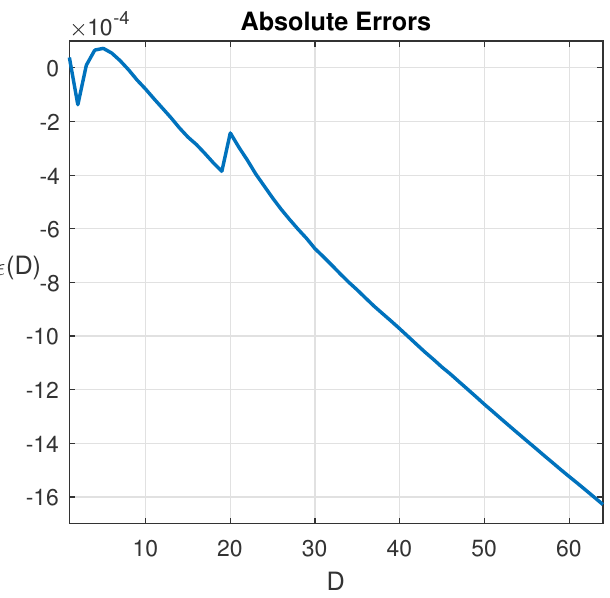
Figure 9. Absolute error between the actual and extrapolated CP